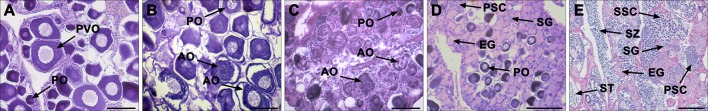
Gonad histology during cortisol-induced sex change from female to male in the orange-spotted grouper. (A) Gonad histology of a female with oocytes. (B) Gonad histology of a female at the early stage of degeneration with atretic oocytes. (C) Gonad histology of a female at the late stage of degeneration, with oocytes undergoing further degeneration. (D) Gonad histologyes of an intersex-transitional phase individual, with the presence of spermatogenic germ cells at various developmental stages and the oocytes in primary growth. (E) Gonad histology of a sex-changed male with active spermatogenesis. AO, atretic oocyte; EG, early germ cell; PO, primary oocyte; PSC, primary spermatocytes; PVO, previtellogenic oocyte; SG, spermatogonia; SSC, second spermatocytes; ST, spermatid; SZ, spermatozoa. Scale bars, 50 μm.